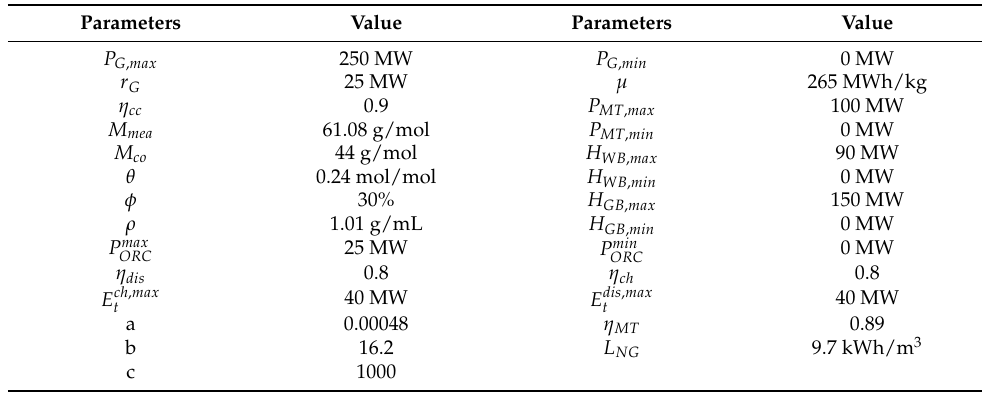
Figure 2. Electrical load and thermal load data. Table 1. Basic parameters.